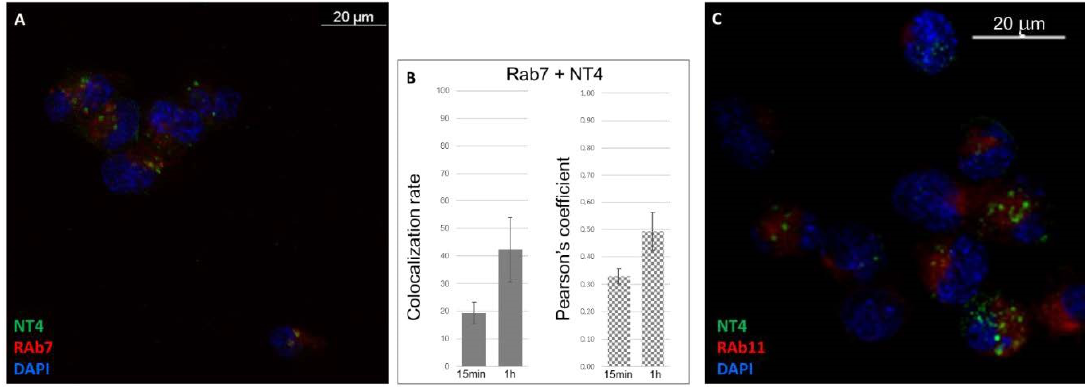
Figure 5. NT4 colocalization with Rab7 and Rab11. ( A ) NT4 and Rab7 after 1 h incubation; ( B ) normalized values of colocalization rate and Pearson coefficient of NT4 and Rab7 after 15 min and 1 h incubation; ( C ) NT4 and Rab11 after 1 h